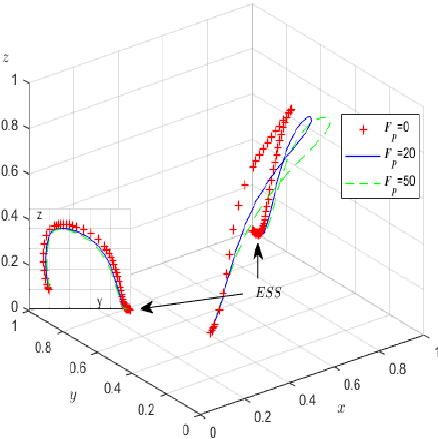
Figure 6. The influence of T p on evolutionary processes.